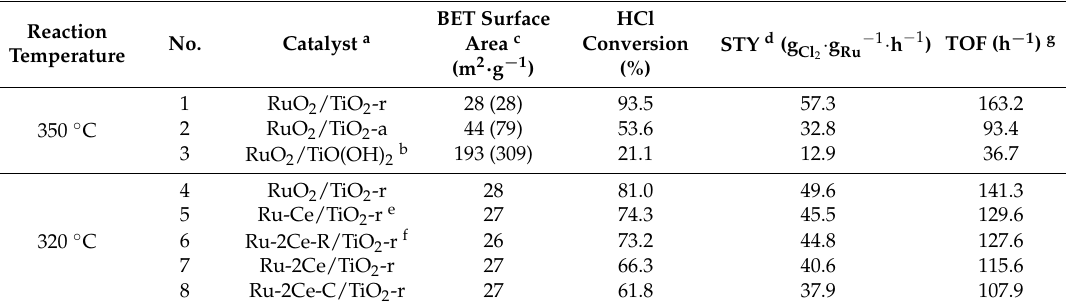
Table 2. Characterization and catalytic activity